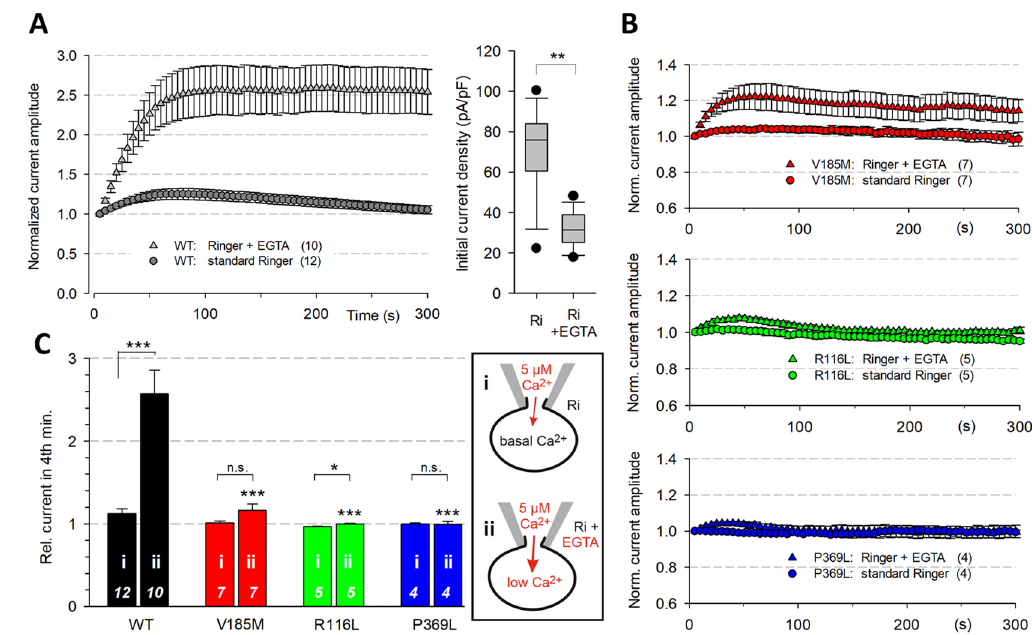
Figure 4. Ca 2+ sensitivity of WT KCNQ1 channels is blunted in the mutant channels. Whole-cell recordings were performed using high-Ca 2+ ICS in CHO cells expressing KCNQ1 channels without overexpression of CaM. Cells were pre-incubated for at least 30 min in normal (i) or EGTA-Ringer solution (ii). ( A ) Time course of WT KCNQ1 current amplitudes traced with a 500 ms test pulse to 40 mV (left panel). Normalized current amplitudes (means ± SEM) for experiments in standard or EGTA-Ringer as ECS. Initial current densities were significantly lower in EGTA-Ringer compared to standard ECS (right panel; ** p < 0.01). ( B ) Time course of normalized current amplitudes (means ± SEM) for experiments on V185M-, R116L- and P369L-KCNQ1 channels in standard or EGTA-Ringer as ECS. ( C ) Comparison of the effects of pre-incubation in EGTA-Ringer on the changes in relative current amplitude for WT and mutant KCNQ1 channels. Asterisks directly above a box indicate significant differences in relative current amplitudes of mutant KCNQ1 channels compared to the WT data obtained under the same experimental conditions. Other asterisks indicate significant differences between conditions “i” and “ii” (see schematic drawings). *** p < 0.001; * p < 0.05; n.s., not significant; numbers of experiments are shown in the